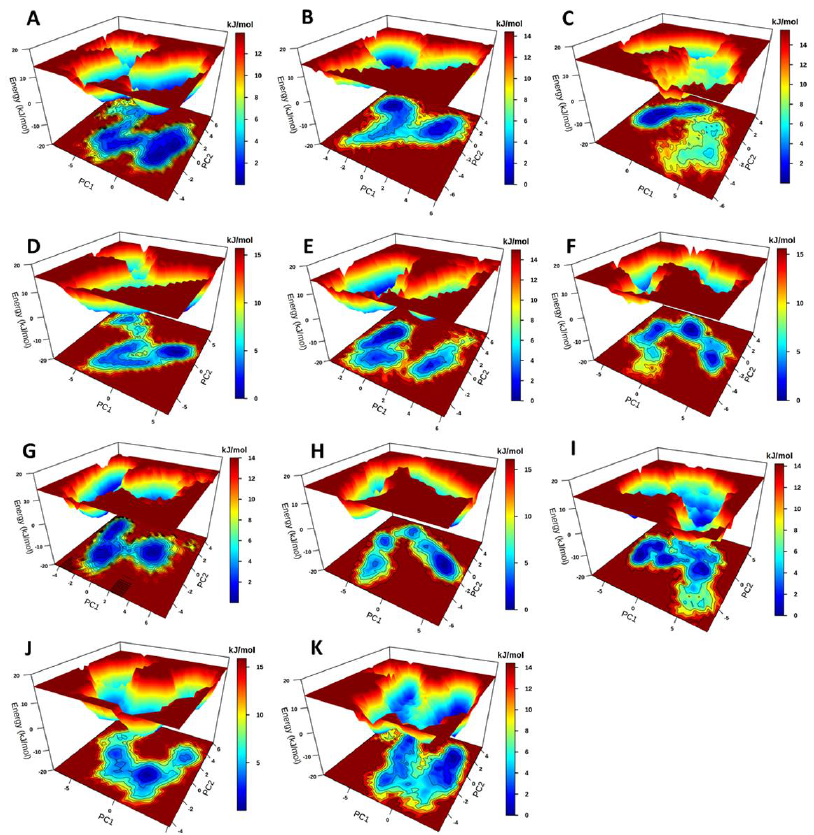
Figure 6. 3D representation of binding free energy landscape as a function of PC1 and PC2. Energy distribution is shown by the coloring pattern: Blue defines the conformational space with minimum energy (stable state) while red defines a conformational space with maximum energy (unstable state). Transient local energy states are defined by intermediate color patterns. PC1 and PC2 are displayed as a contour map at the bottom of each FEL plot with similar color pattern like the energy landscape. ( A ) Holo protein (PfProRS-ADN), ( B ) PfProRS-SANC152 complex, ( C ) PfProRS-SANC235 complex, ( D ) PfProRS-SANC236 complex, ( E ) PfProRS-SANC244 complex, ( F ) PfProRS-SANC318 complex, ( G ) PfProRS-SANC184 complex, ( H ) PfProRS-SANC257 complex, ( I ) PfProRS-SANC264 complex, ( J ) PfProRS-SANC456 complex and ( K ) PfProRS-SANC622 complex.